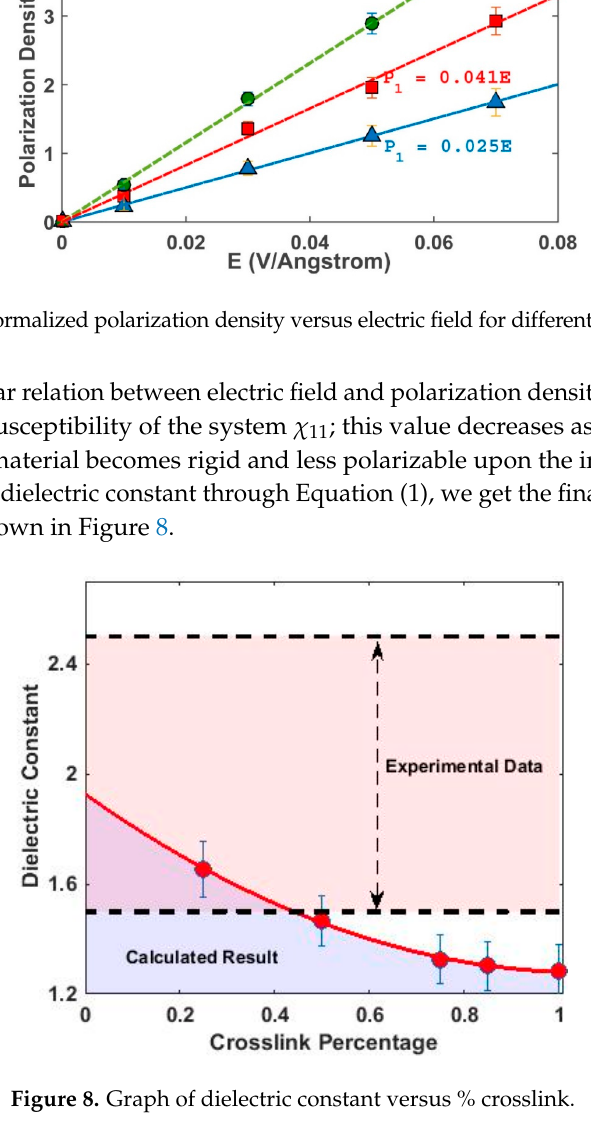
Figure 8. Graph of dielectric constant versus % crosslink.